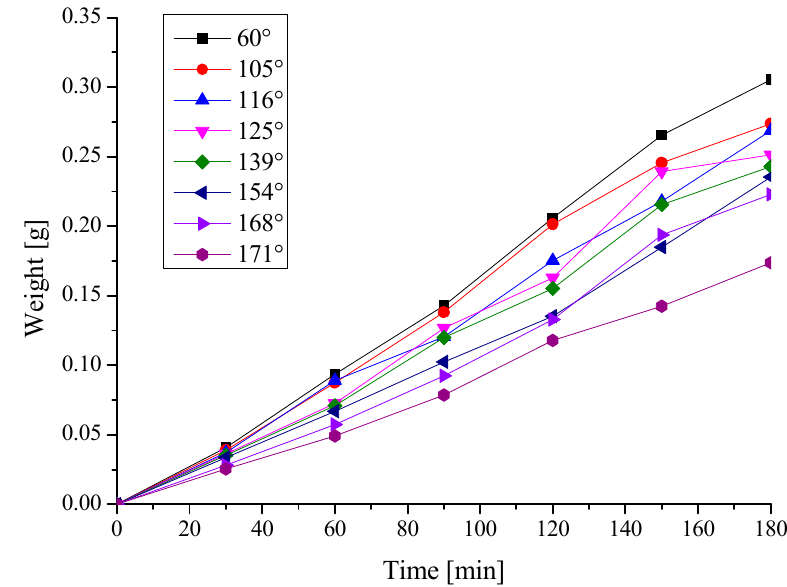
Figure 8. Variations of frost weight with different contact angles.